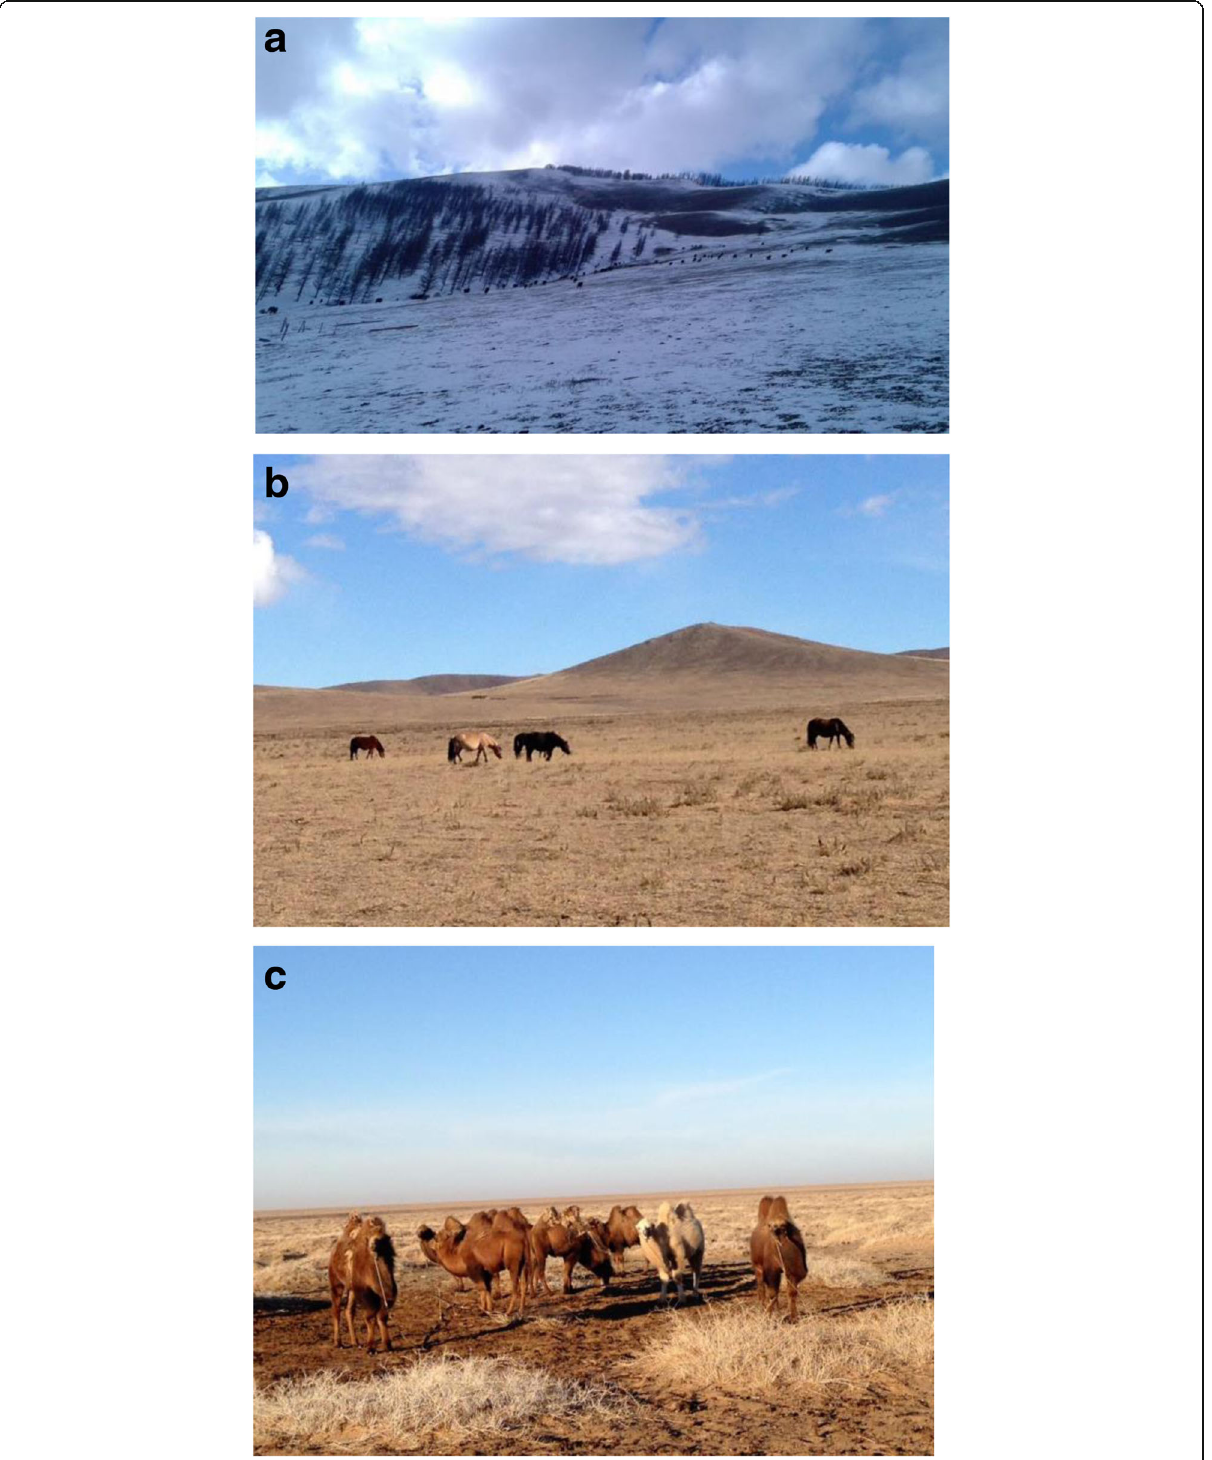
Figure 2 Photographs of the representative topography from each aimag. The three study sites represent different regions. Arkhangai ( a ) is primarily mountainous with scattered forests, Uvurkhangai ( b ) is primarily steppe, and Umnugobi ( c ) consists of desert and desert